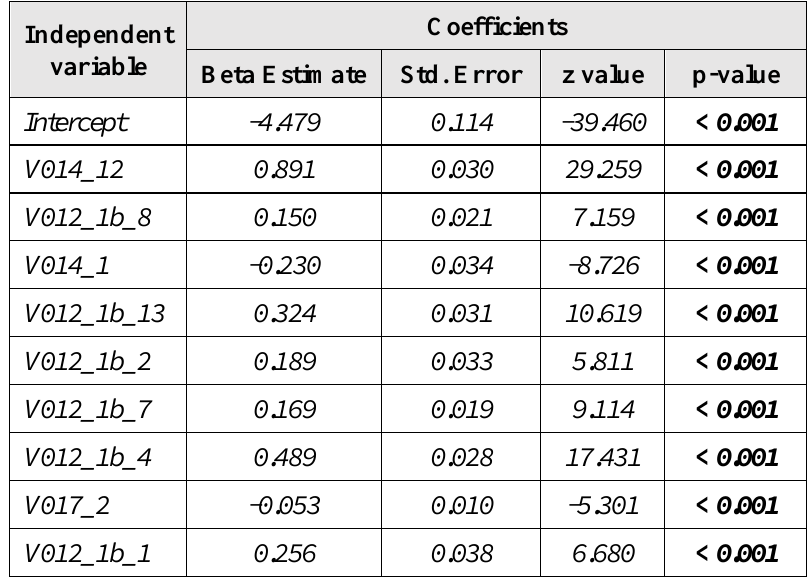
Table 3. Binary logistic regression model for fatigued